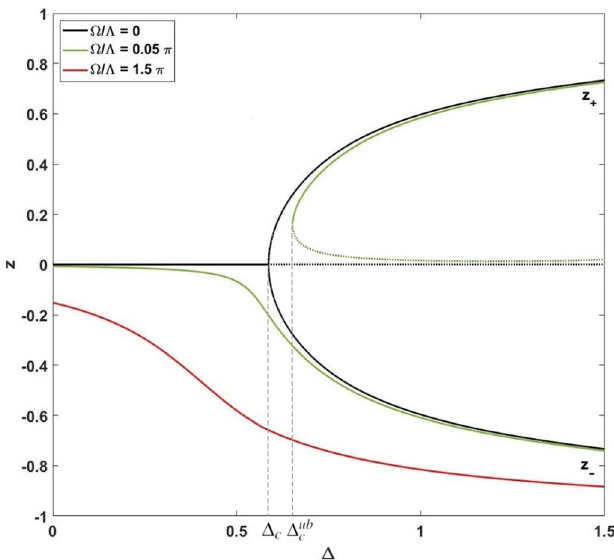
0 and different (cid:31) . The solid curves denote SS solutions of =